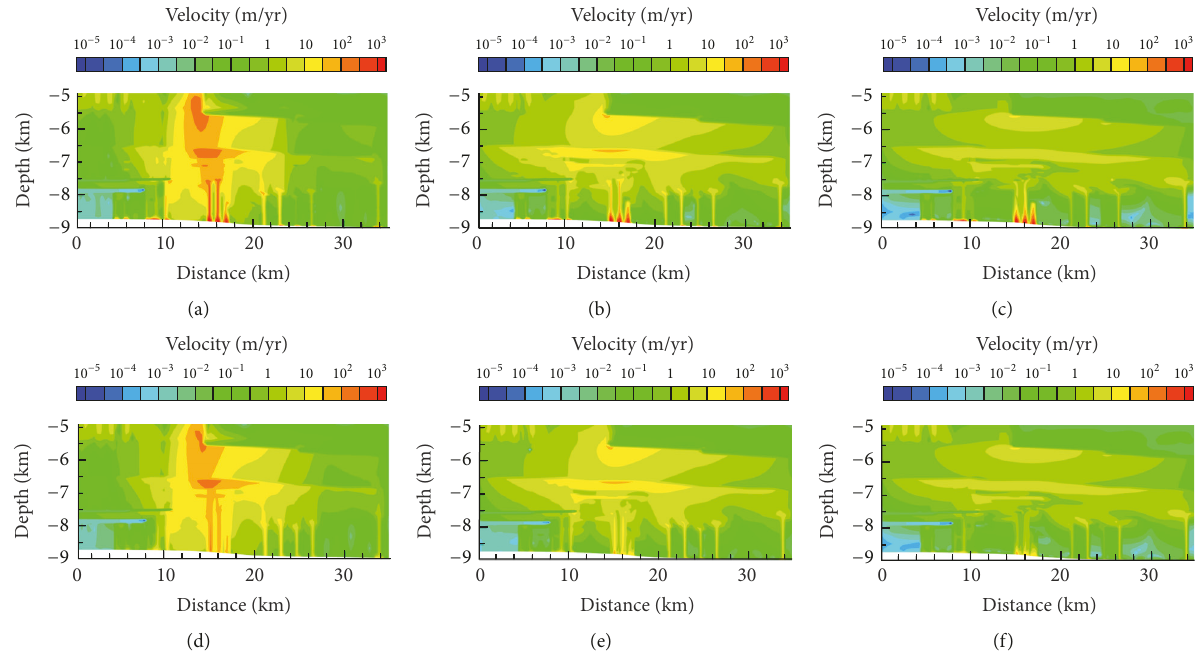
Figure 13: The fluid velocity for Scenario I with fault permeability of 1 × 10 −13 m 2 : (a) 𝑘 h : 𝑘 v = 1 , (b) 𝑘 h : 𝑘 v = 10 , and (c) 𝑘 h : 𝑘 v = 100 and fault permeability of 1 × 10 −15 m 2 : (d) 𝑘 h : 𝑘 v = 1 , (e) 𝑘 h : 𝑘 v = 10 , and (f) 𝑘 h : 𝑘 v = 100 .